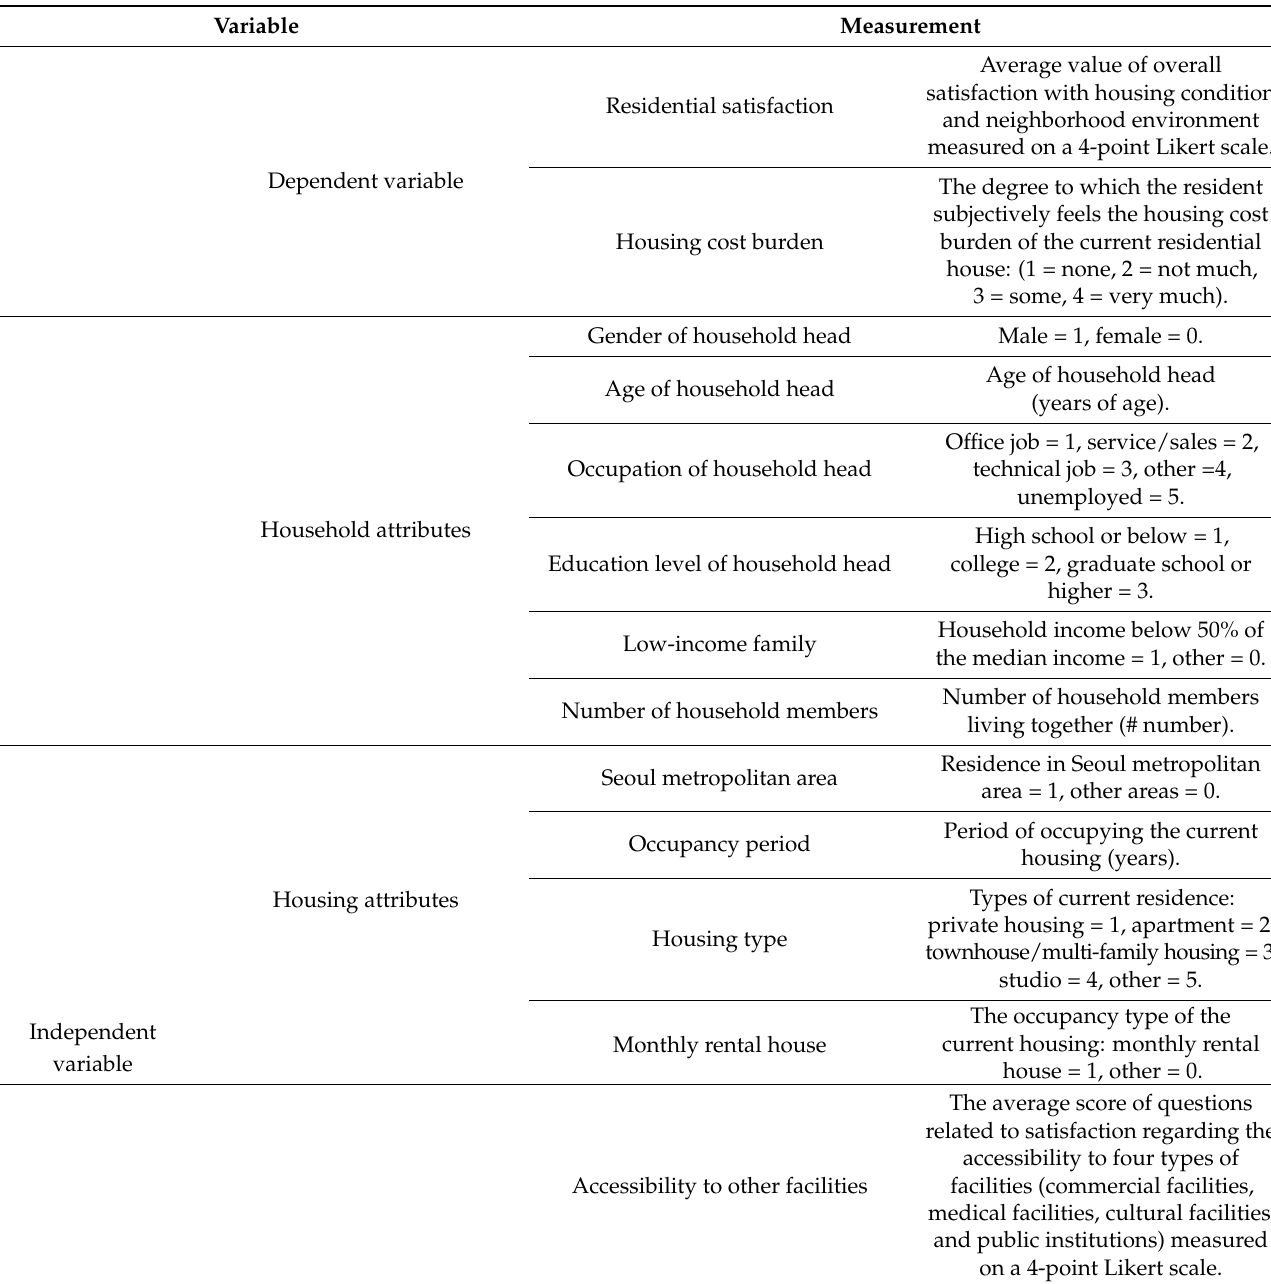
Table 1. Variable